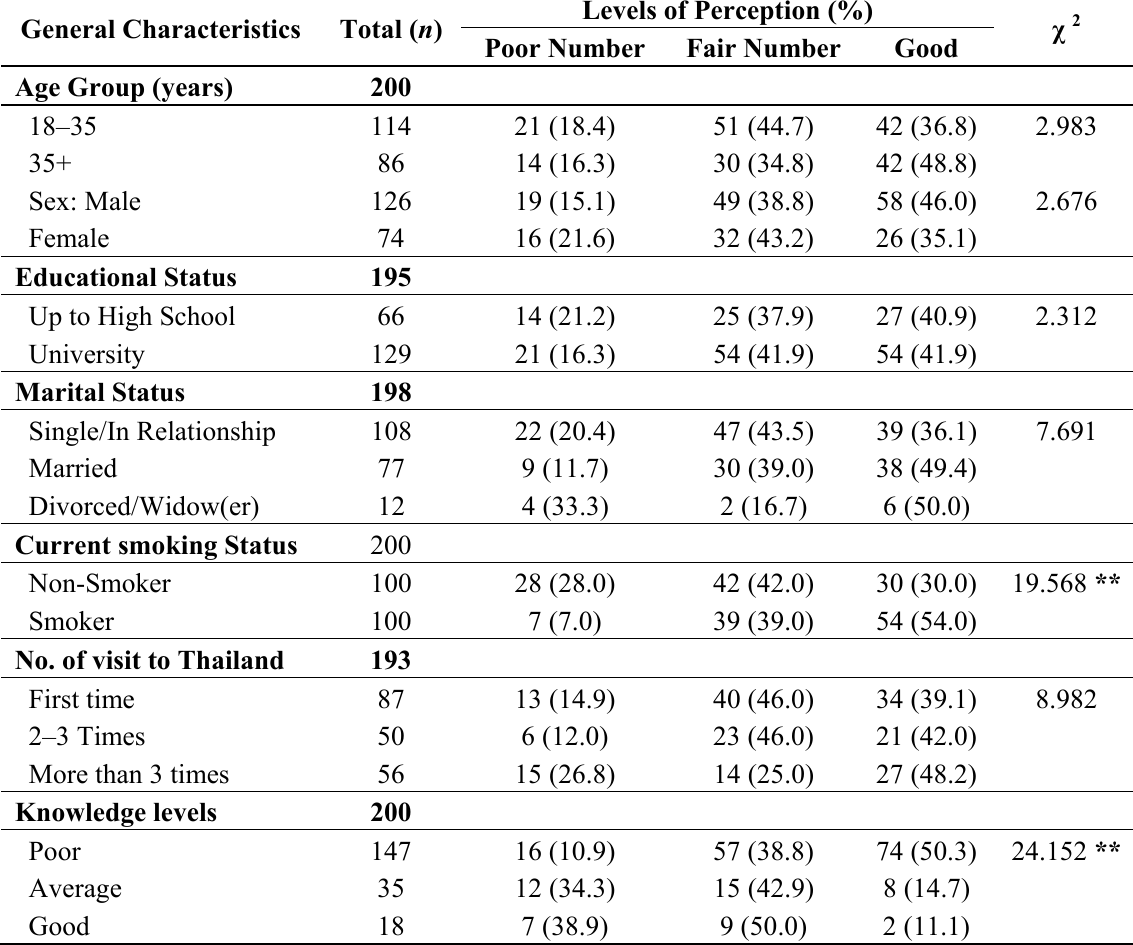
Table 4. Association between general characteristics and perception on smoke-free